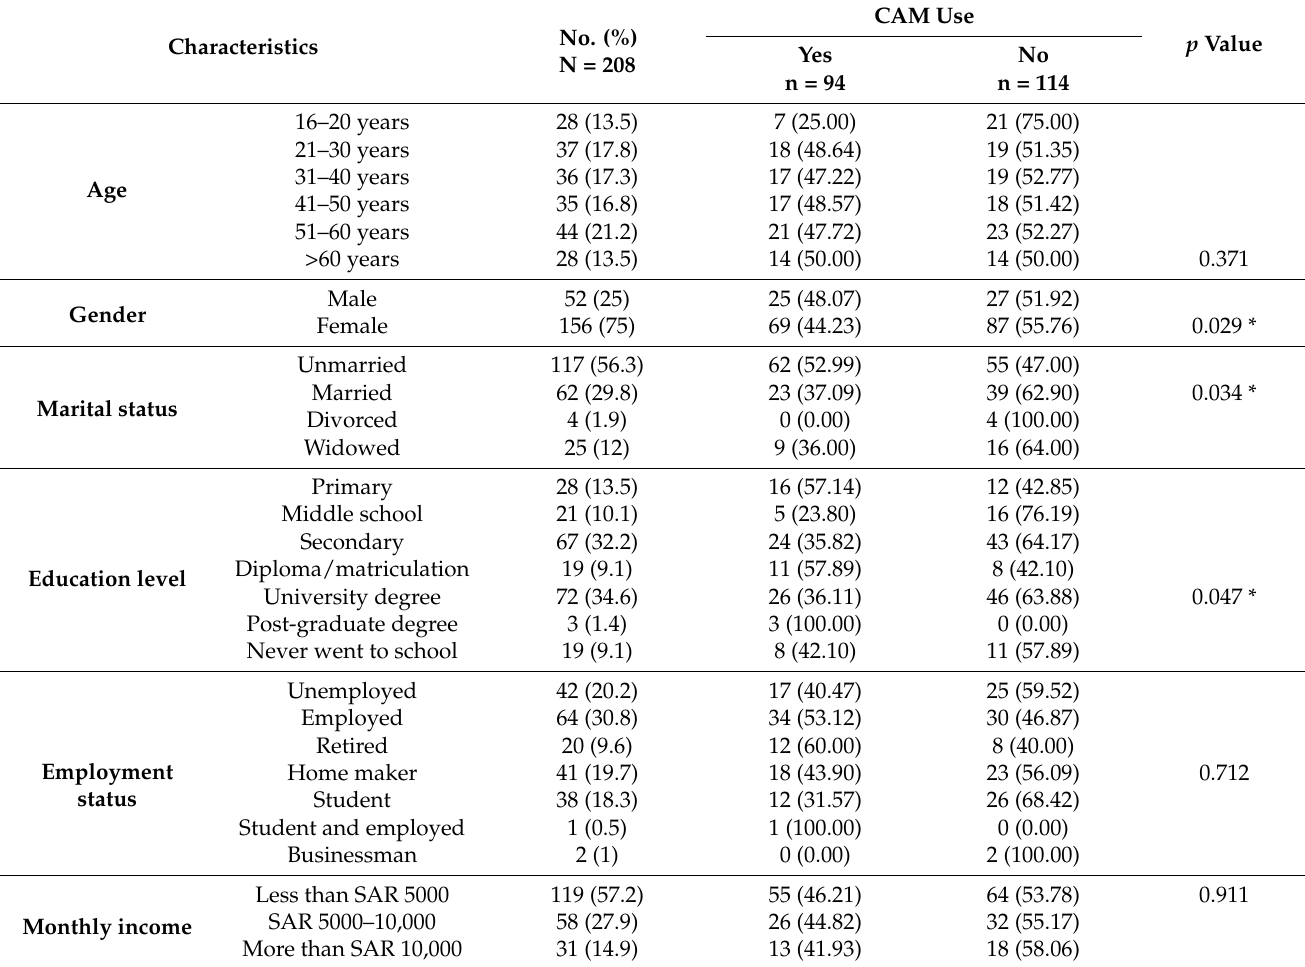
Table 1. Demographic characteristics of the CD patients and their CAM